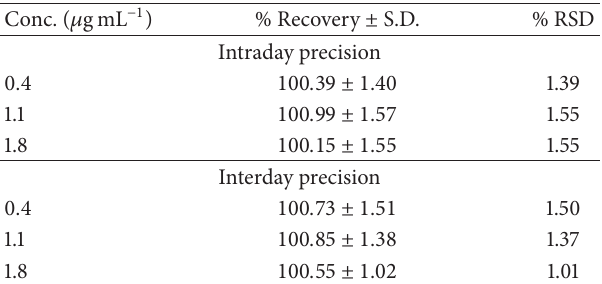
Table 4: Precision data for the proposed method.